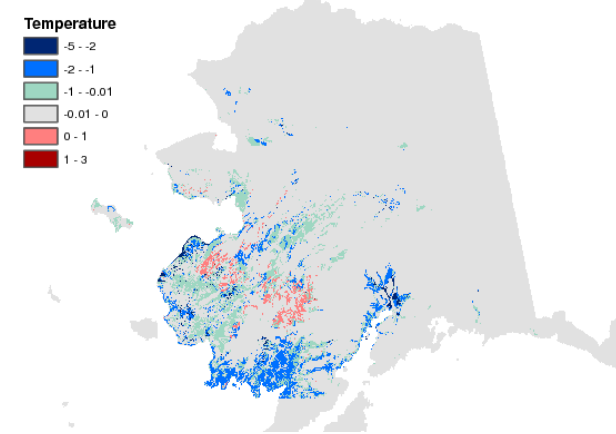
Fig. 10. Projected differences between MAGTs simulated with and without additional organic layer(s) at 1m depth for year